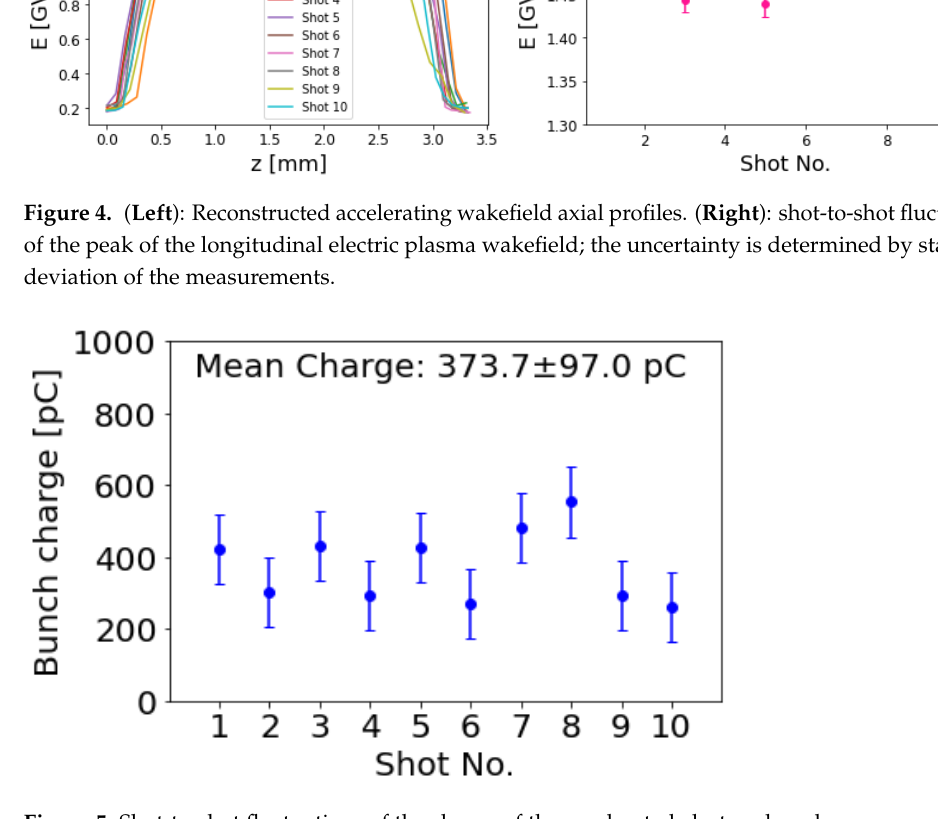
Figure 5. Shot-to-shot fluctuations of the charge of the accelerated electron bunches.